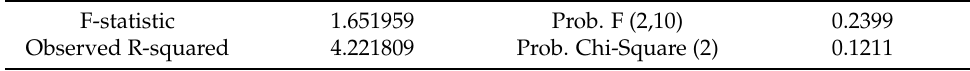
Table 1. Breusch-Godfrey Serial Correlation Lagrange Multiplier